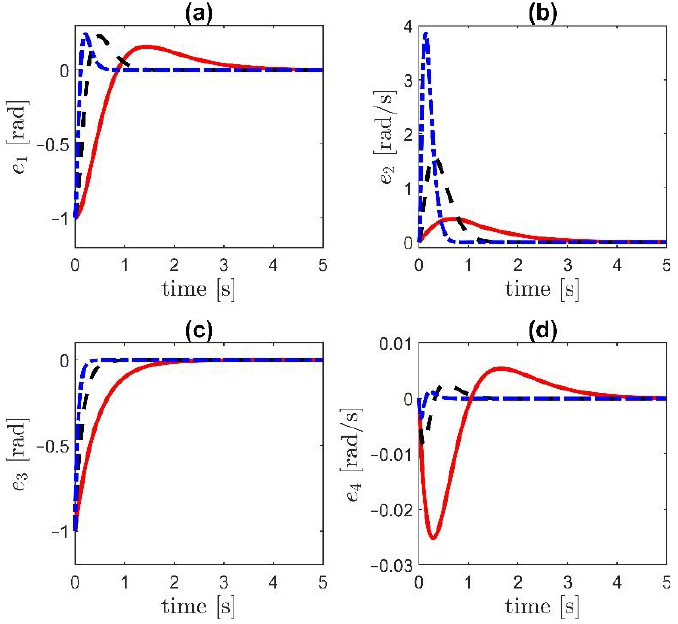
Figure 7. Observer errors 𝑒 1 ( a ), 𝑒 2 ( b ), 𝑒 3 ( c ), and 𝑒 4 ( d ). Dashed blue line — 𝛼 = 7 , dash-dotted black line — 𝛼 = 3 , solid red line — 𝛼 = 1 .